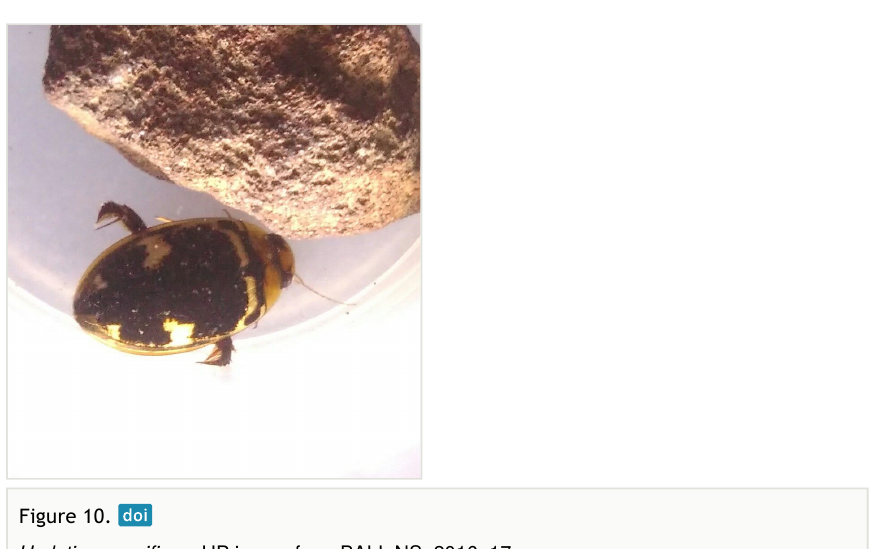
Hydaticus paci fi cus (Fig. 10).